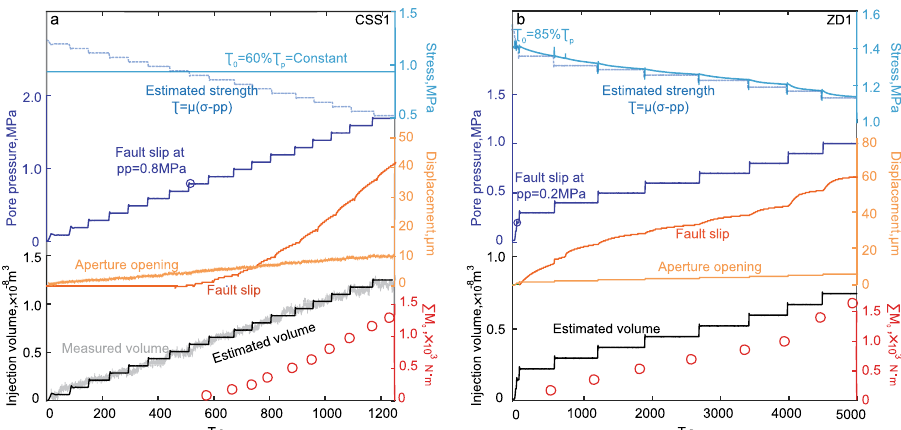
Fig. 1 Typical observed fault displacement and cumulative moment over time as induced by fl uid injection. The reactivated laboratory faults are under boundary conditions of ( a ) constant shear stress and ( b ) zero displacement. Measured variables and axes are color-coded to show the time evolution of fault fl uid pressure, injection volume, fault slip and dilation, instantaneous strength, and cumulative